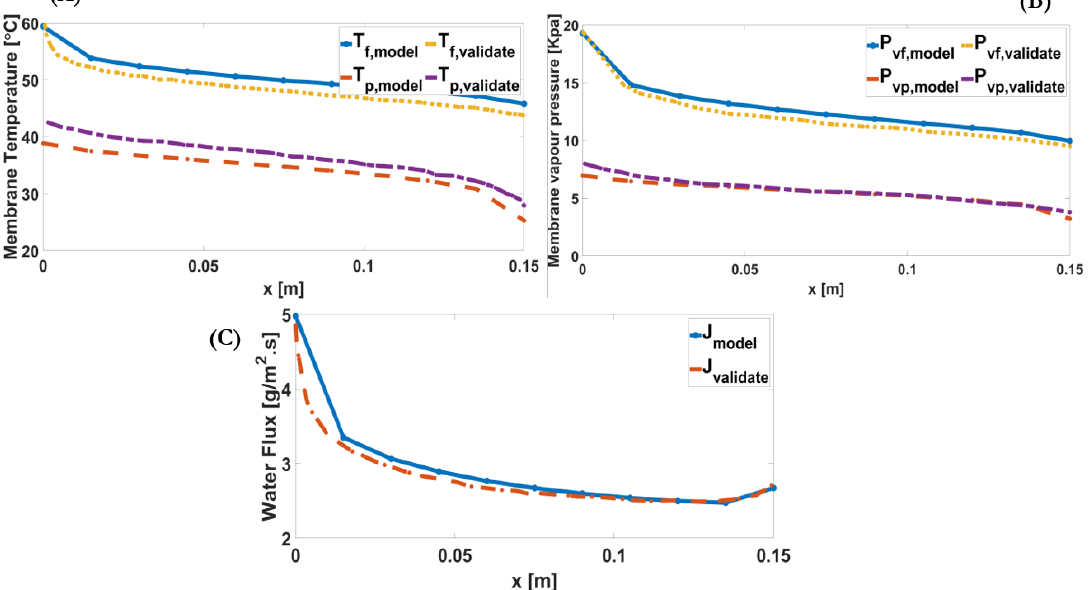
Figure 5. ( A ) Downstream alterations of feed and permeate membrane temperatures validated by the reference model [21]. ( B ) Downstream alterations of the membrane water vapour pressures of the feed and permeate validated by the reference model [21]. ( C ) Downstream alterations of the transmembrane mass flux validated by the reference model (less than 7% deviation) [21].